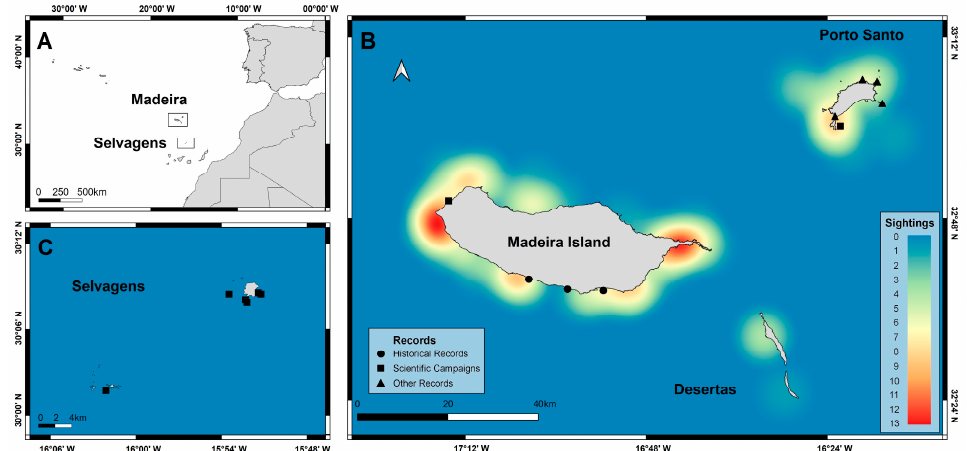
Figure 1. Map of the Madeira Archipelago showing ( A ) the location of the study area in the Northeast Atlantic, including ( B ) Madeira Island, Porto Santo, Desertas, and ( C ) the Selvagens Islands and locations of Chilomycterus reticulatus sightings around the Archipelago of Madeira between the years 1898 to 2021. Heatmap colors display hotspots of first sightings obtained by the online survey. Records from museum records ( ● ), scienti fi c campaigns ( ■ ), and other sources ( ▲ ) are also displayed.